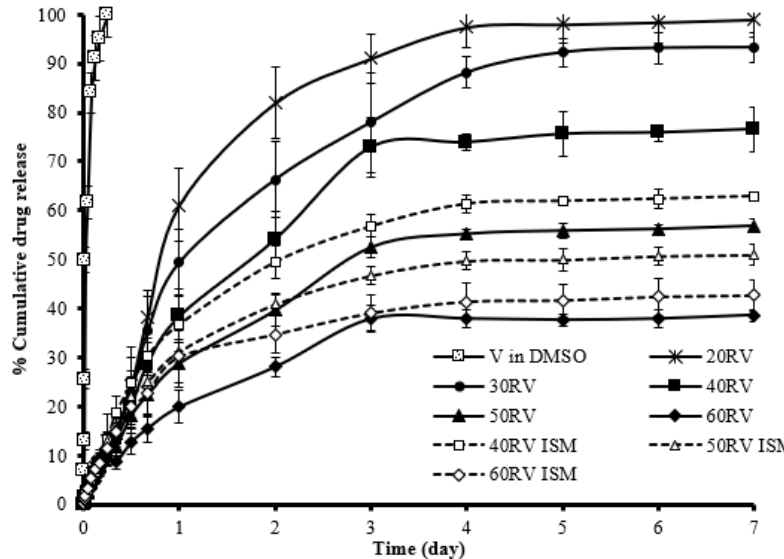
Figure 5. Release of vancomycin HCl from DMSO, ISG, and ISM formulations containing rosin as the gelling agent and the matrix forming agent, respectively, using the dialysis method ( n = 3). Table 4. Comparison of the degrees of goodness-of-fit from curve fitting the release profiles of van- comycin HCl released from rosin-based ISG and ISM in PBS pH 6.8 using the dialysis membrane method for the different release models.